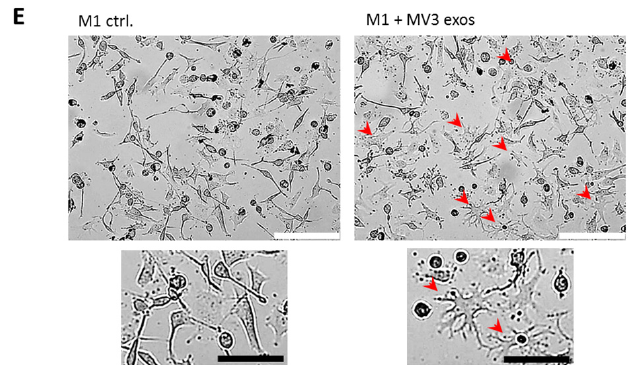
Figure 2. Melanoma exosomes induce a proinflammatory and proangiogenic phenotype macrophages. ( A ) Hierarchical clustering of differential transcripts of THP-1-derived M1 macrophages 48 h co-cultured with MV3 melanoma cells, treated with MV3 released exosomes or M1 macrophages alone. ( B ) Gene ontology and Reactome pathway analysis of genes significantly increased in M1 macrophages after treatment with melanoma-derived exosomes. ( C ) Gene set enrichment analysis (M1 + exosomes versus M1 control) of next-generation sequencing results shows induction of inflammation, angiogenesis, and leukocyte chemotaxis. ( D ) Quantitative RT-PCR validated induction of proinflammatory, proangiogenic, and chemotaxis-related gene expression after 48 h co-culture of M1 with MV3 cell line or treatment with melanoma cell-derived exosomes. Bars represent the average ± standard deviation of at least three independent experiments (* p ≤ 0.05; ** p ≤ 0.01; *** p ≤ 0.001; ns: not significant). ( E ) Bright-field microscopy shows representative morphological changes (red arrows) of THP-1-derived M1 macrophages with and without MV3- derived exosomes treatment (48 h). White scale bar: 200 µm; black scale bar: 50 µm.